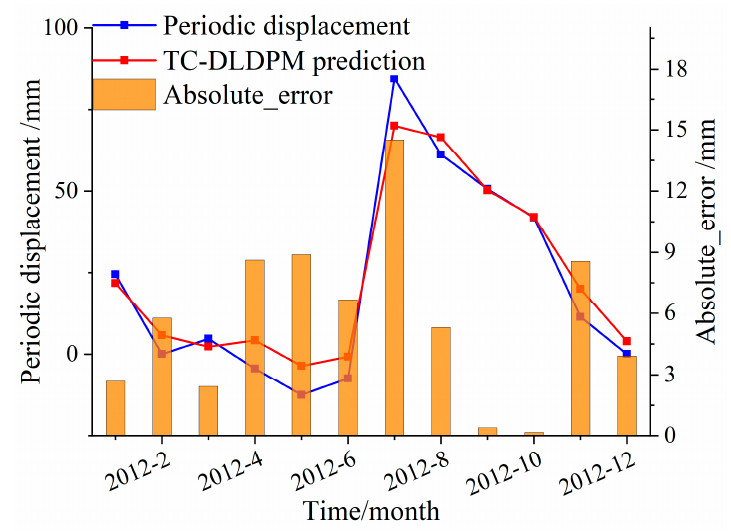
Figure 18. Displacement prediction results of periodic term on the ZG110 testing data.